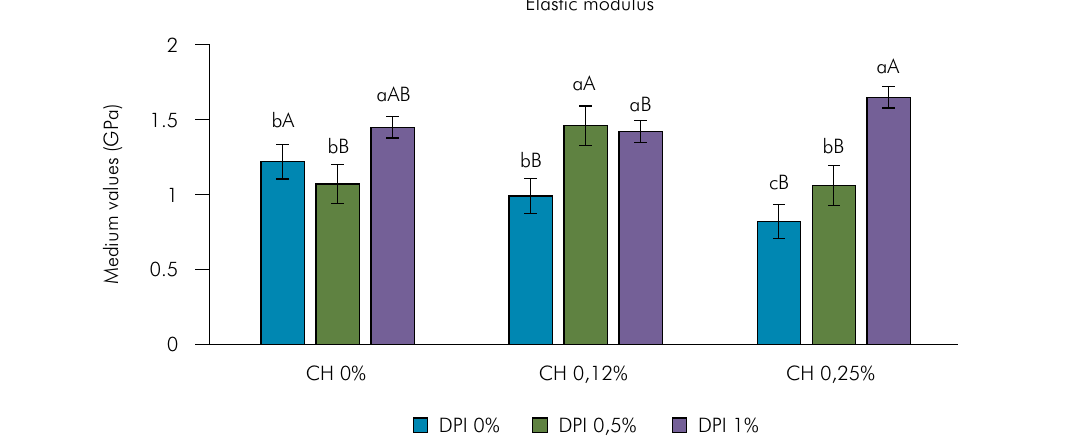
Figure 2. Mean values of elastic modulus (GPa) of experimental infiltrants, according to DPI (mol%) and chitosan (w%) concentrations.